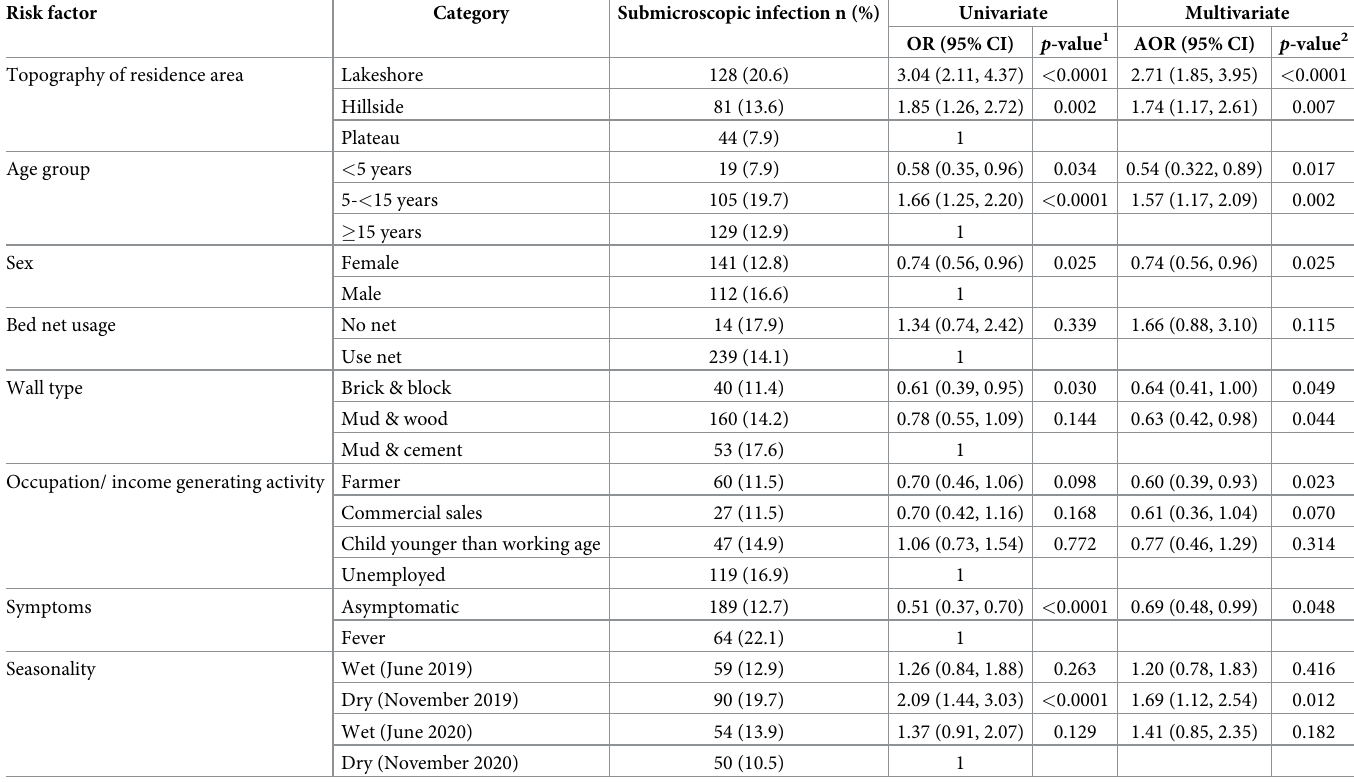
Table 3. Predictive factors associated with submicroscopic malaria